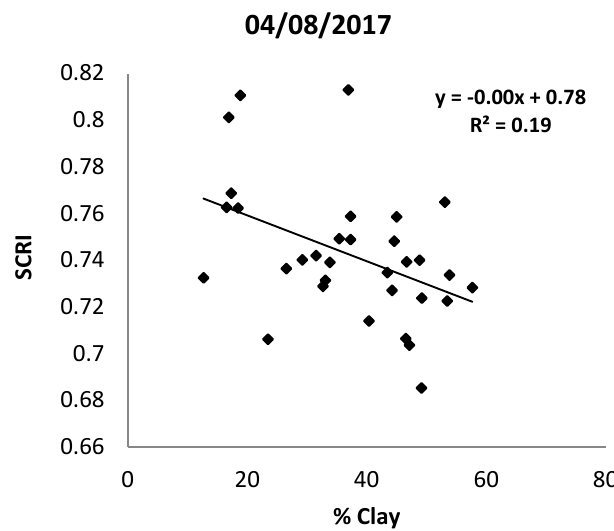
Figure 6. Clay content as a function of the simple ratio clay index (SRCI).